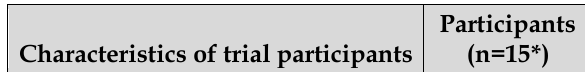
Table 2 Characteristics of participants who performed translations during the